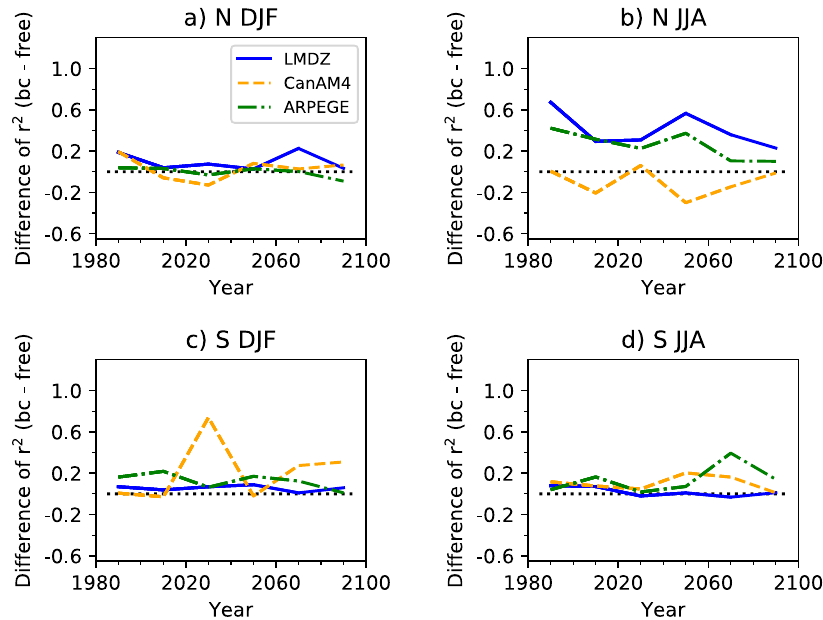
Fig. 3 Interannual variability of extratropical circulation. Squared spatial correlation coef fi cient ( r 2 ) of the fi rst EOF of monthly mean extratropical (polewards of 30°N and S) 500 hPa geopotential (20-year periods), bias-corrected minus uncorrected simulation. a Northern hemisphere winter (DJF); b Northern hemisphere summer (JJA); c Southern hemisphere winter (DJF); d Southern hemisphere summer